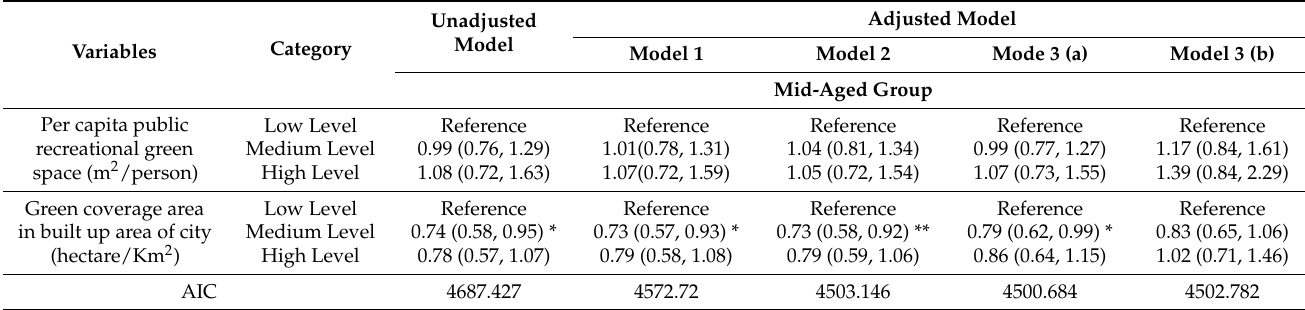
Table 4. Results of multilevel logistic models of depressive symptoms by age